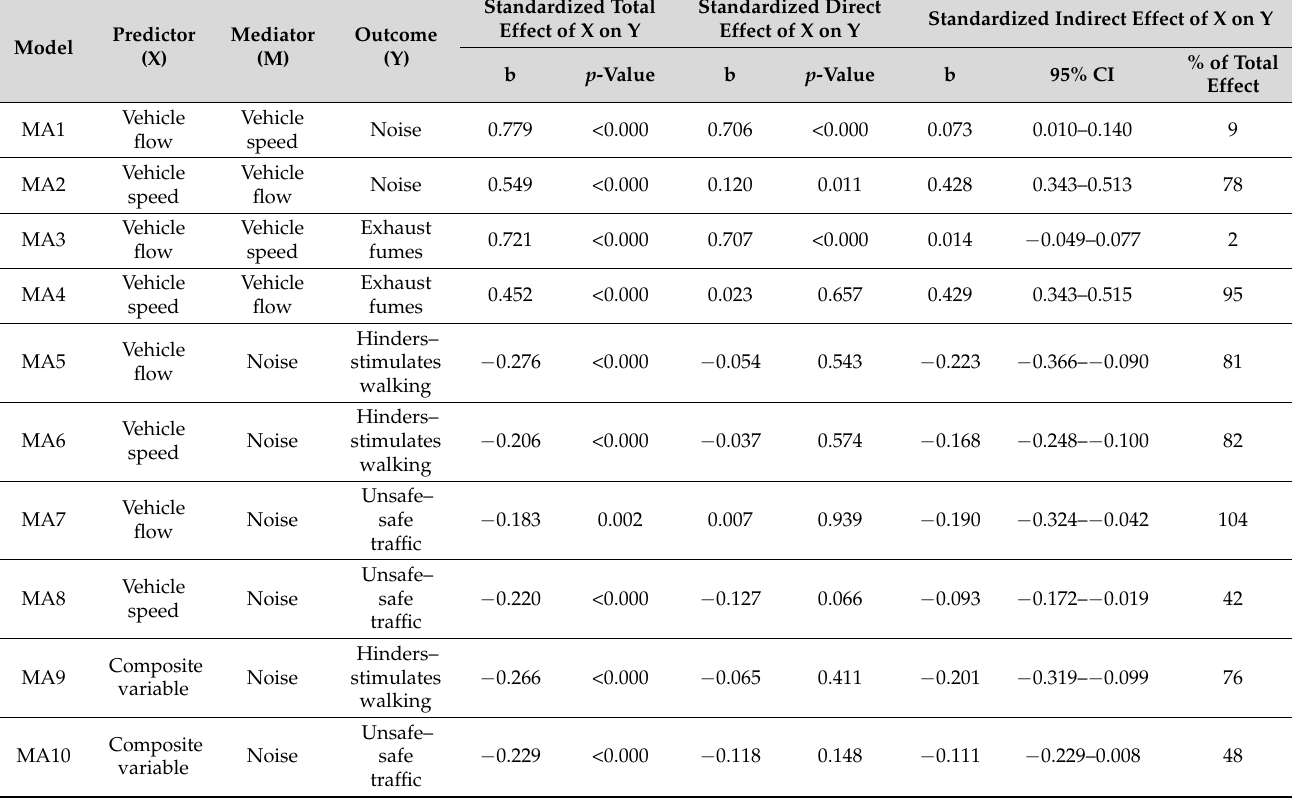
Table 9. Mediation analyses between the four predictor variables of motor traffic (MA1–MA4), between the same predictor variables and the two outcome variables (MA5–MA8), as well as between the composite variable ( vehicle flow × vehicle speed ) and the outcome variables (MA9–MA10). Standardized Total Effect of X on